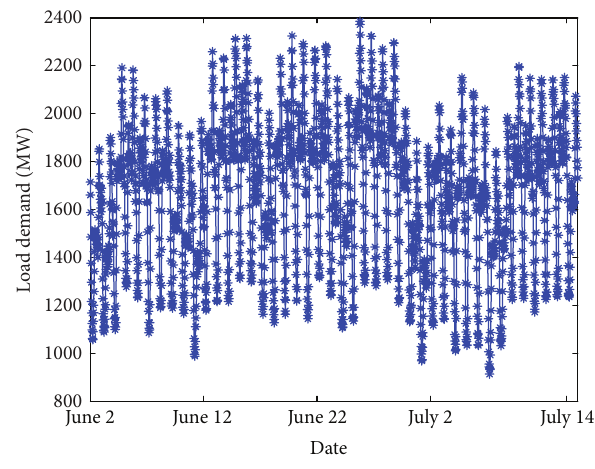
Figure 1: Load demand of SA from June 2, 2007 to July 14, 2007.